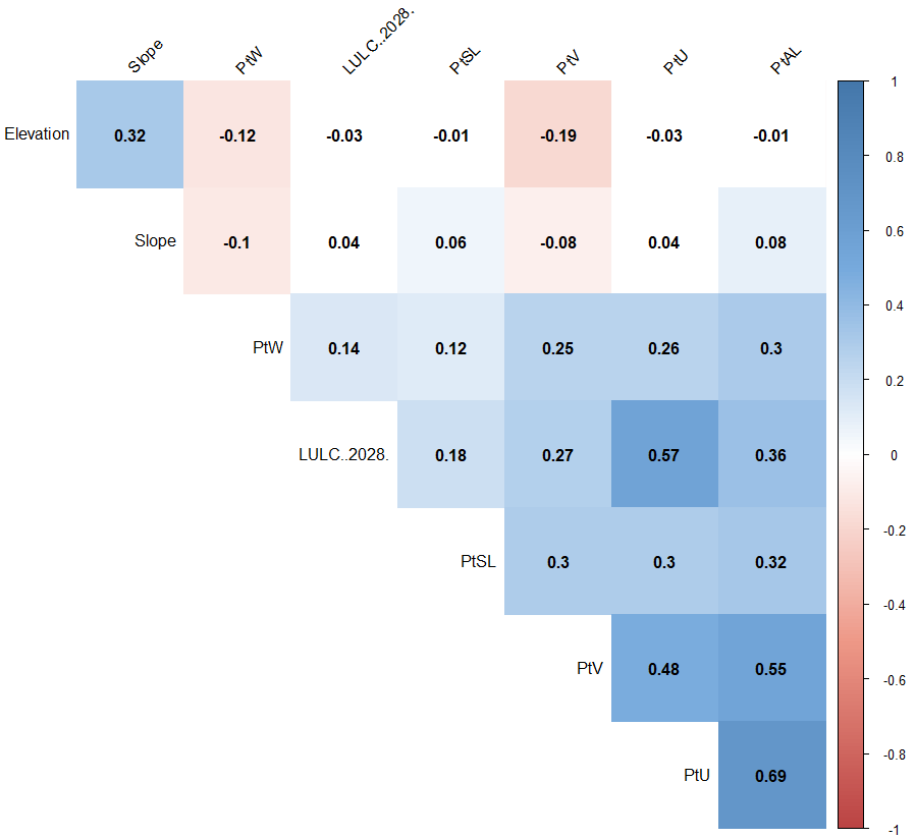
Figure 5. Correlation between the predicted LULC of 2028 and LULC change conditioning parameters. PtW: proximity to water bodies, PtSL: proximity to scrub land, PtV: proximity to vegetation, PtU: proximity to urban areas, PtAL: proximity to agricultural land.